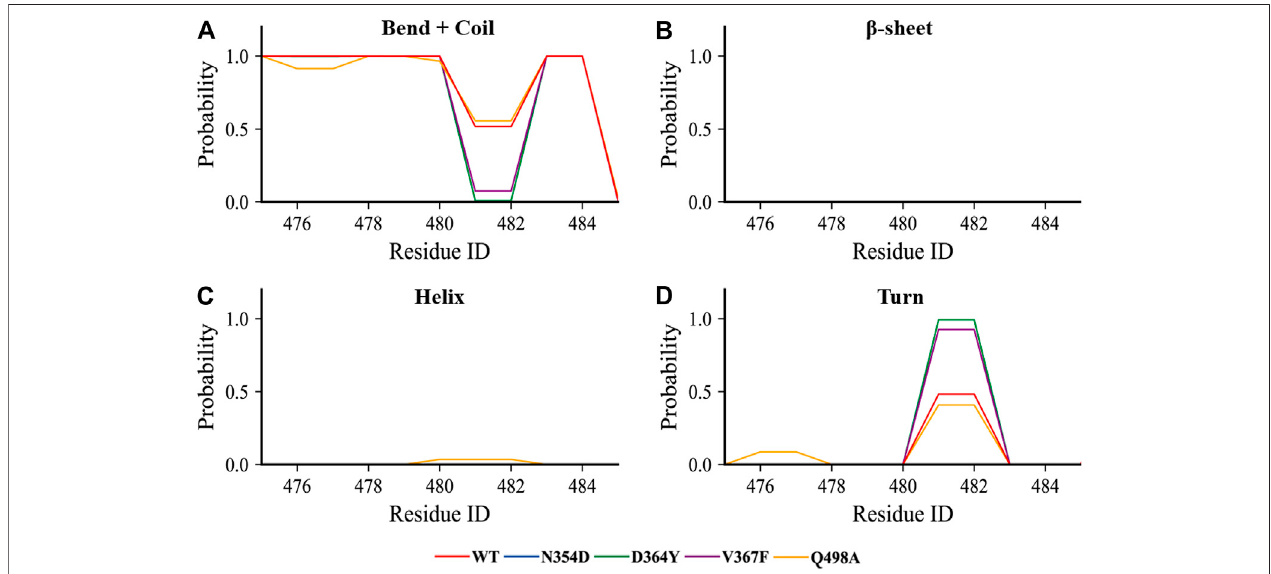
FIGURE 5 | The content of various secondary structures in the region (Ala475-Gly485) in the RBD of each system. (A – D) The proportions of the four secondary structures in this region are bend + coil, β -sheet, helix, and turn.